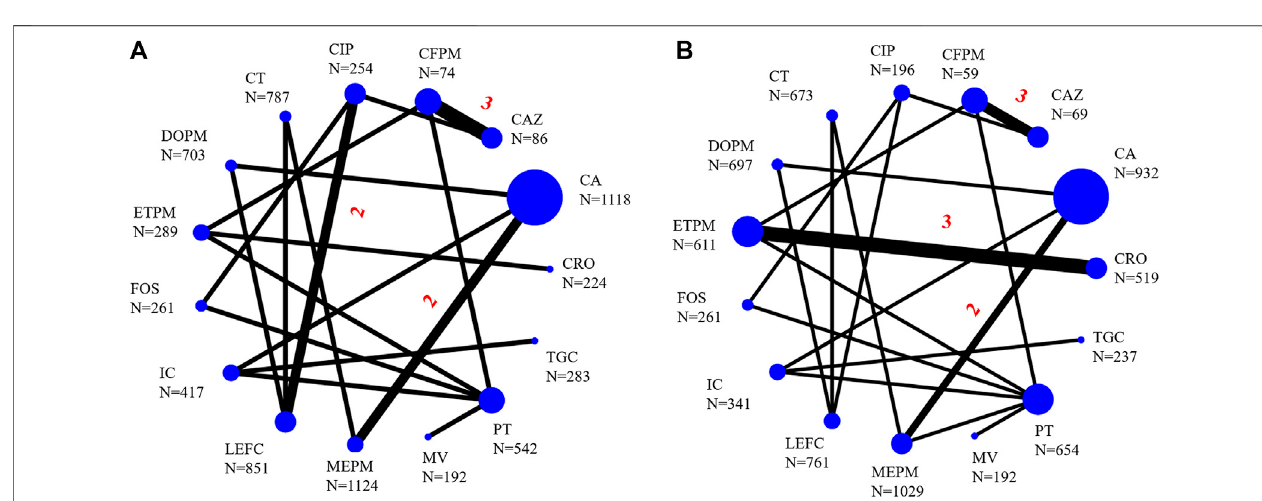
FIGURE 2 | Network of eligible comparisons for primary outcomes [ (A) , clinical success; (B) , microbiological success]. Straight-line represented direct comparisons of antibacterial drugs, the thickness of which corresponded to the number of included studies, the unmarked number means there was only one head-to- head comparison. N was the sample size corresponding to the antibiotics. CA, ceftazidime/avibactam; MV, meropenem/vaborbactam; MEPM, meropenem; DOPM, doripenem; IC, imipenem/cilastatin; CAZ, ceftazidime; CFPM, cefepime; CIP, cipro fl oxacin; PT, piperacillin/tazobactam; ETPM, ertapenem; LEFC, levo fl oxacin; FOS, fosfomycin; CT, ceftolozane/tazobactam; TGC, tigecycline; CRO, ceftriaxone.